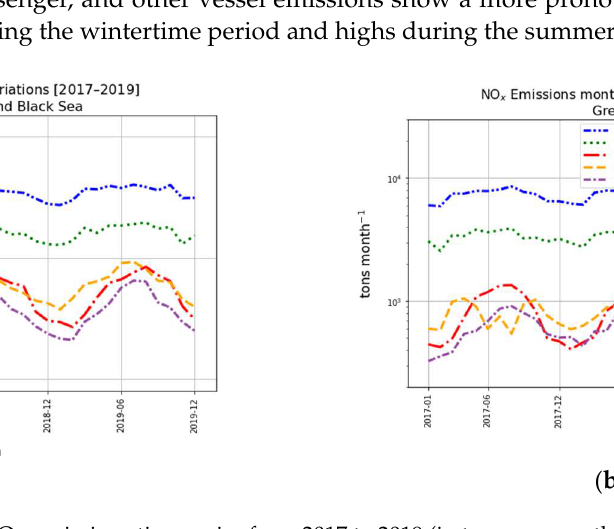
Figure 7. CAMS-GLOB-SHIP NO X emissions time series from 2017 to 2019 (in tons per month) classified according to the EMODnet vessel density data of all the available years: Cargo vessels in blue, tanker vessels in green, fishing vessels in orange, passenger vessels in red and other vessels in purple; ( a ) Mediterranean and Black Sea; ( b ) Greek domain.